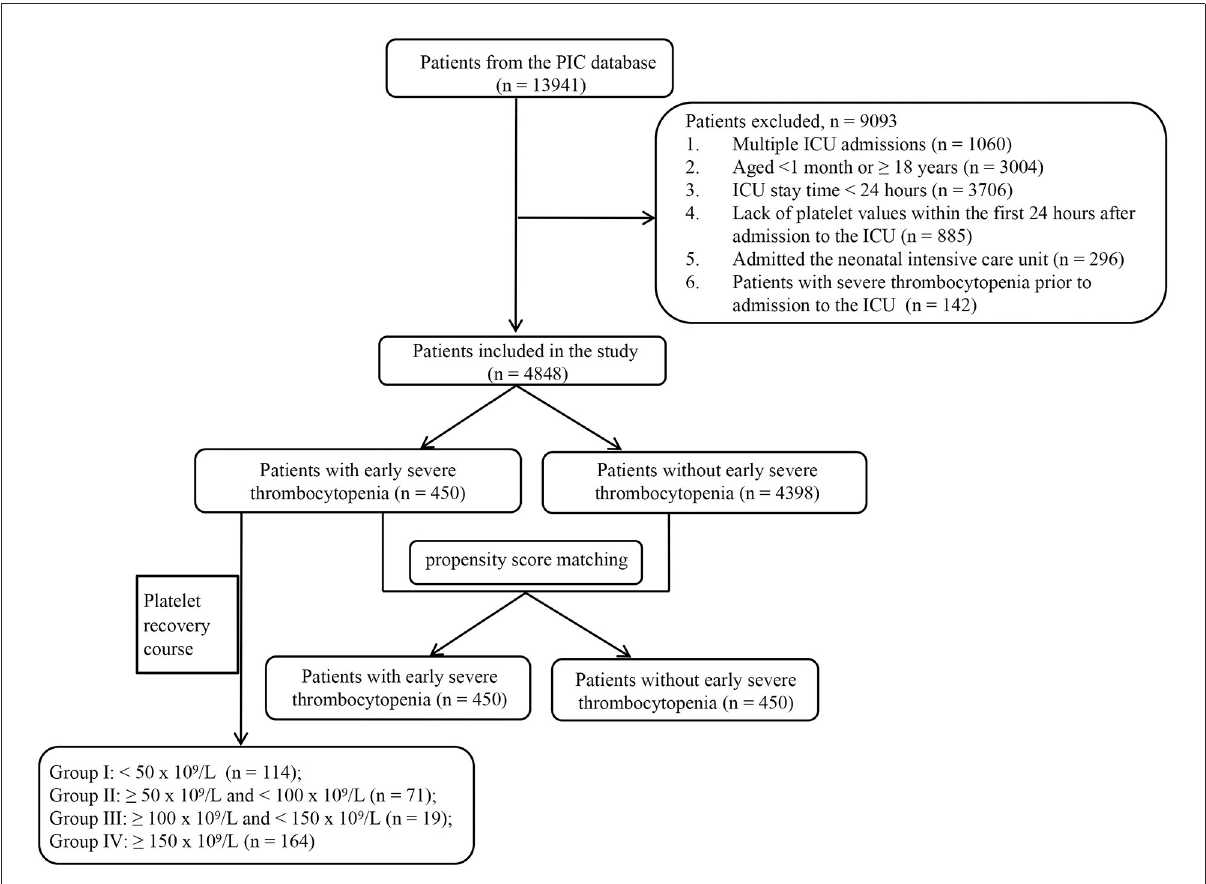
FIGURE1 Flowchart for screening the study population.